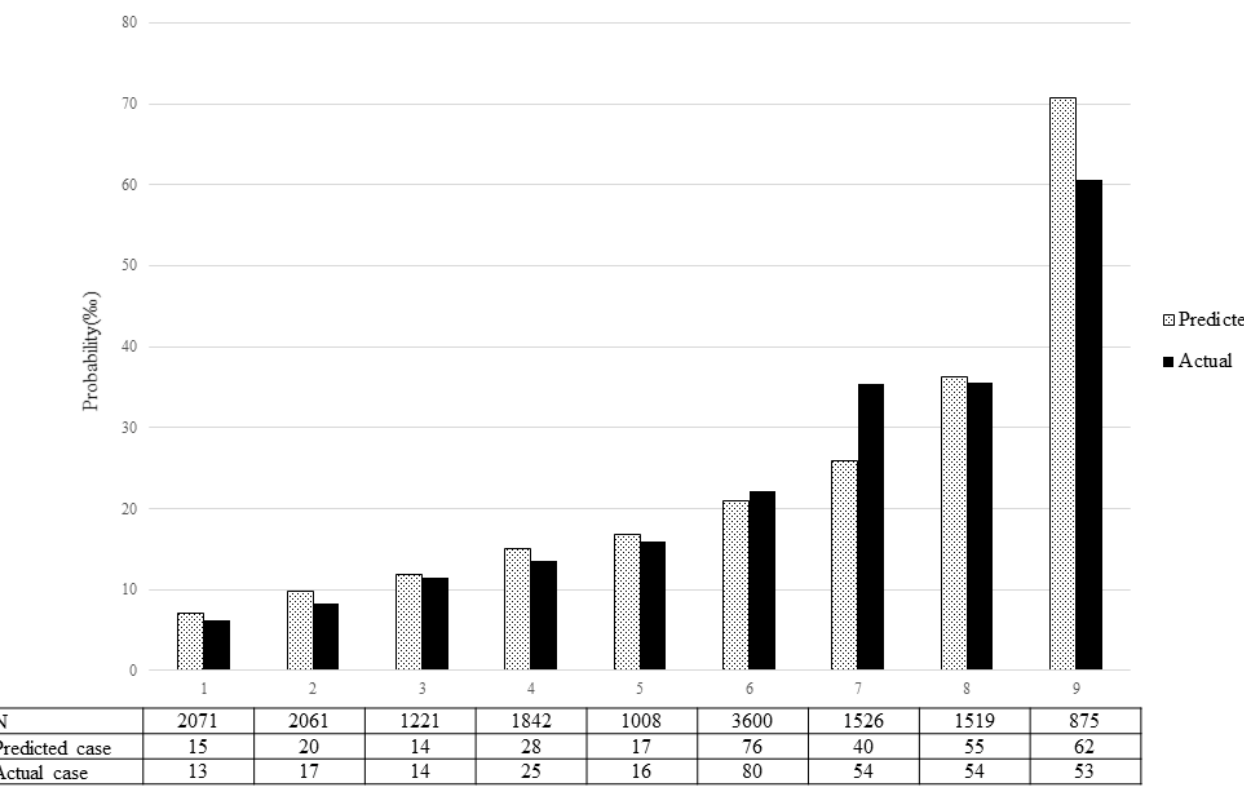
Figure 3. ROC curve in training group ( a ) and validation group ( b ). ROC, receiver operating characteristic.